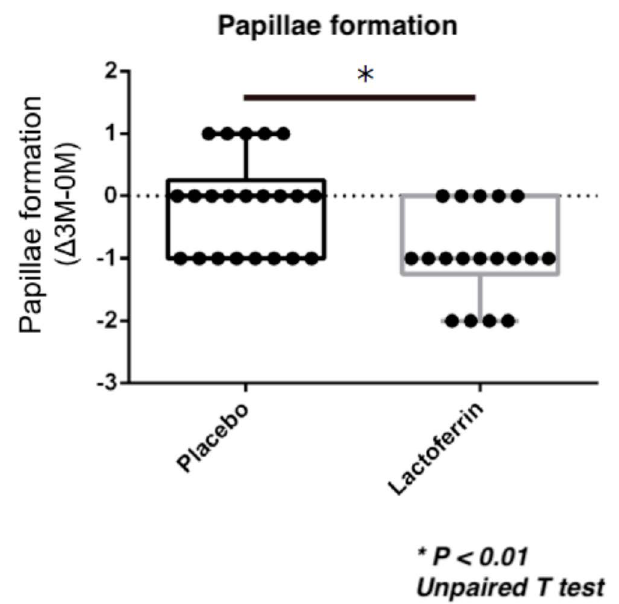
Figure 2. Conjunctival papillae formation in the enteric-coated LF (eLF) with TALYMUS ® group compared to that in the placebo group (12-week treatment). Both groups were also treated with 0.1% tacrolimus ophthalmic suspension. Papillae formation in the palpebral conjunctiva was evaluated using the following clinical evaluation criteria for allergic conjunctival diseases: diameter > 0.6 mm (3), diameter 0.3–0.5 mm (2), diameter 0.1–0.2 mm (1), and no manifestation (0). Horizontal bar represents the groups and vertical bar represents the score; papillae formation score changed over the 12-week treatment (Month–0 Month). * p < 0.01, Unpaired T test.